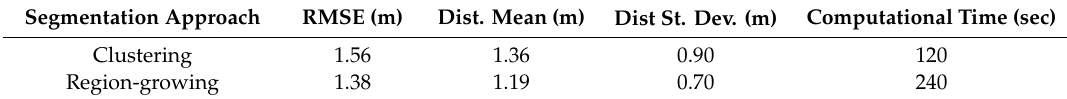
Figure 6. Results of the models for 3D reconstruction of the building located in Matera. ( a ) Light detection and ranging (LIDAR) points provided by GEOCART; ( b ) 3D Building Information Modeling (BIM) building reconstruction; ( c ) 3D building reconstruction using the clustering segmentation approach; ( d ) 3D building reconstruction using the region growing segmentation approach. Table 2. Performances of the geometry accuracy of each of the two fully automatic reconstruction approaches compared with the 3D BIM model for the case study in Matera (Italy).